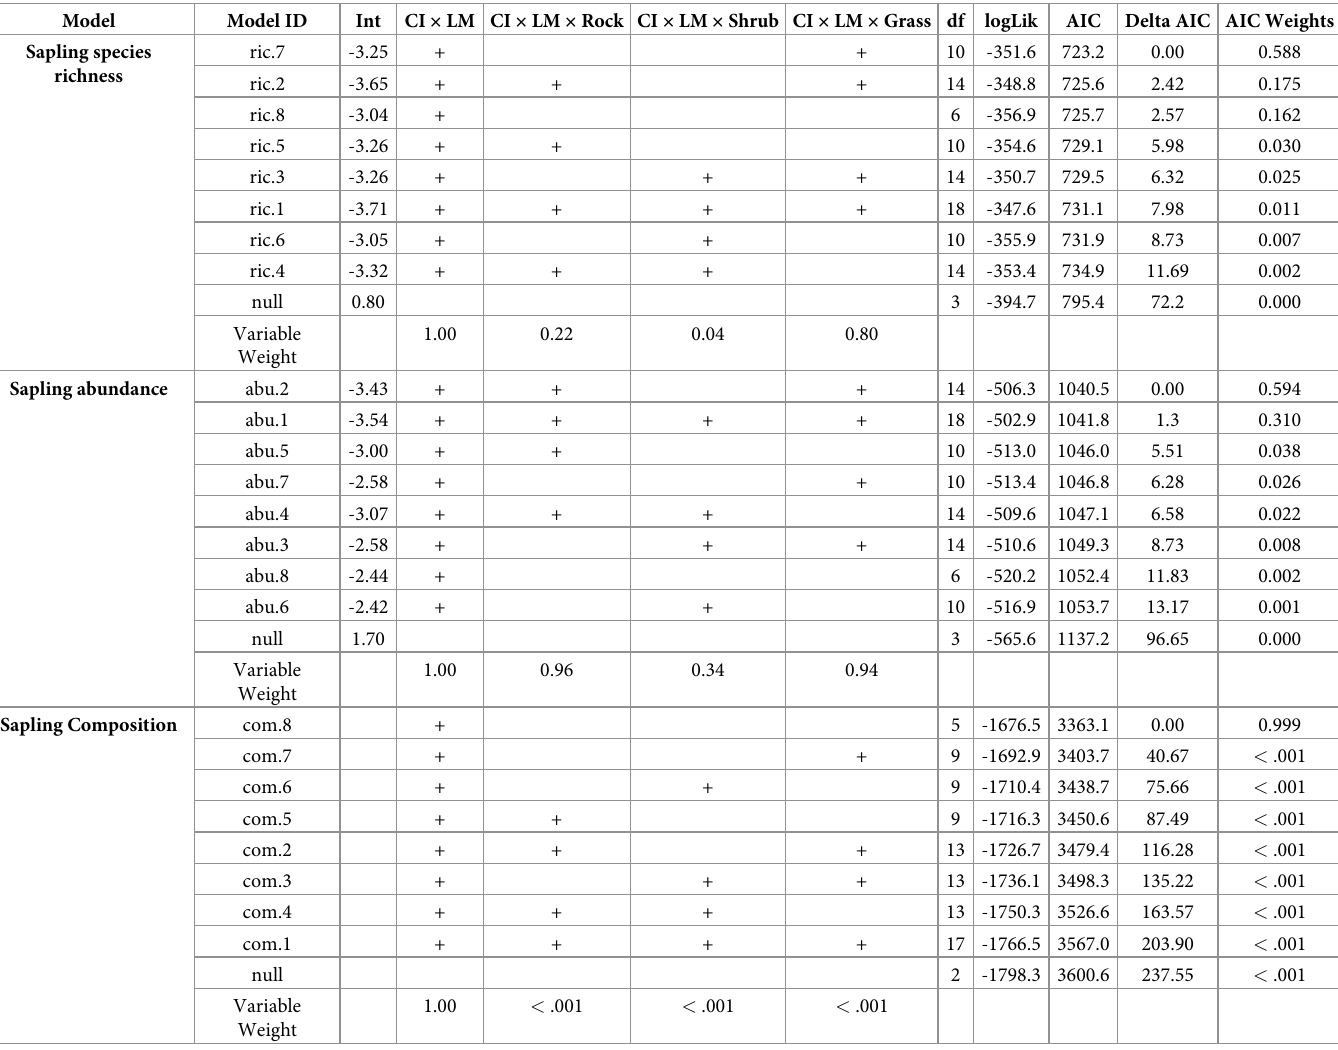
Table 1. Set of produced models for evaluating sapling species richness, abundance and composition in an upper-montane Araucaria forest, southern Brazil. Model Model